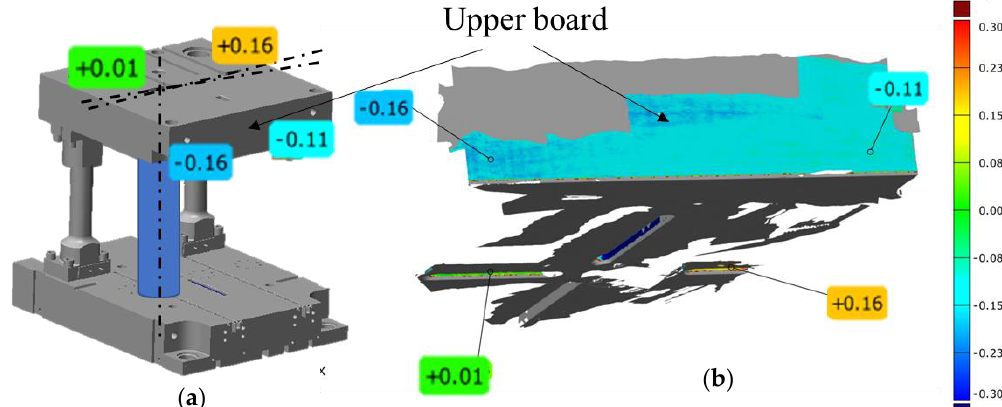
Figure 5. Results of the analysis of the change in the position of the SMED system components on the press in the simulated forging process: ( a ) diagram, ( b ) color map of deviations with 3D scanning results .